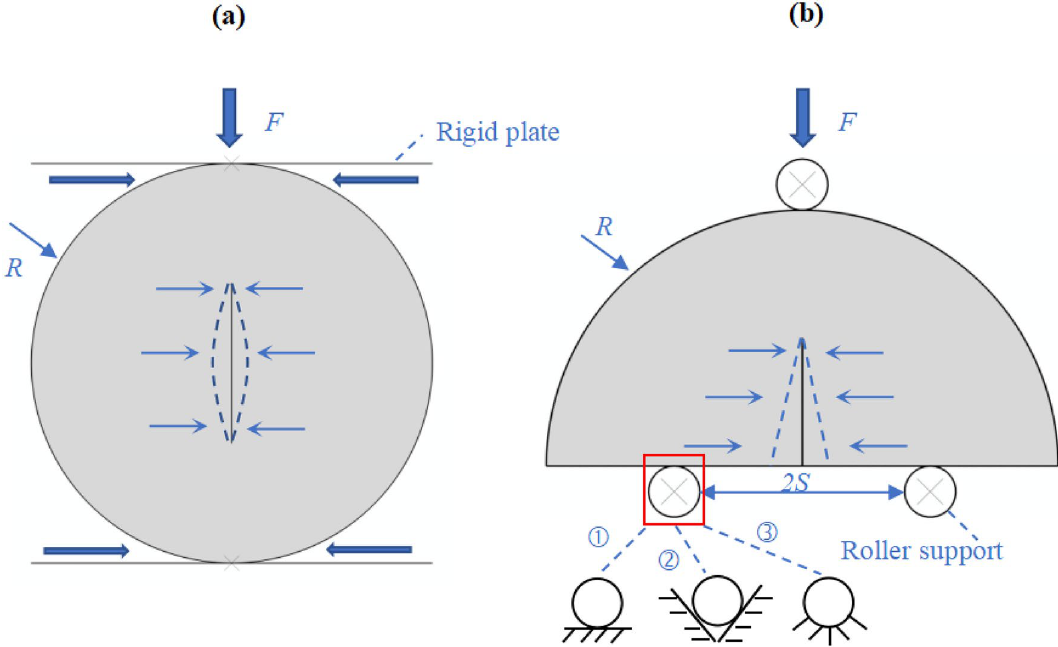
Figure 1. Loading diagram of rock specimens with ( a ) CSTBD configuration and ( b ) NSCB configuration. The three common placement methods of roller support for NSCB configuration: ① free placement; ② put it into the V-shaped groove; ③